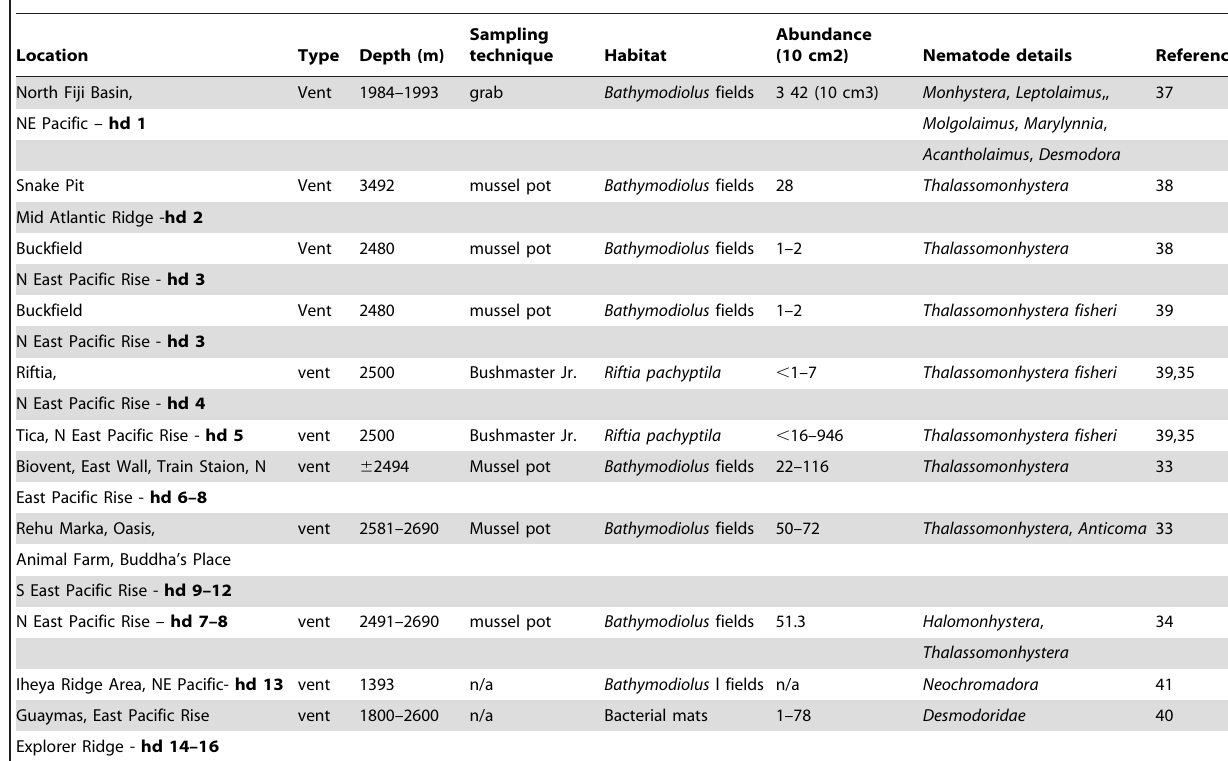
Table 3. Nematodes at deep hydrothermal vents.